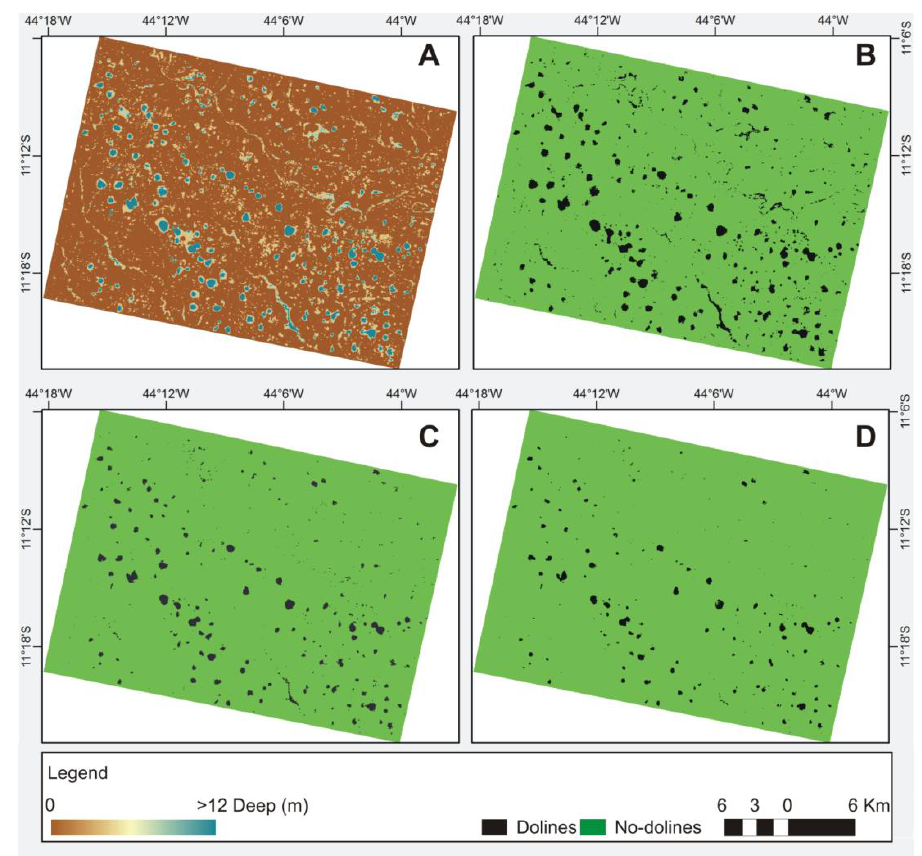
Figure 8. Depth image from ( A ) ALOS/PRISM-DEM and binary mask images made